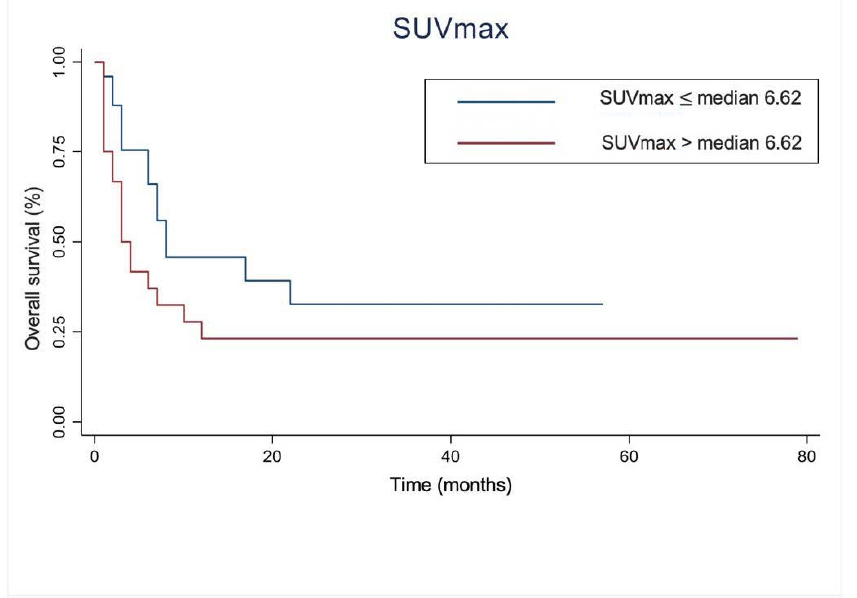
Figure 1. Kaplan–Meier curves for overall survival in restaging melanoma with respect to maximum standard uptake value (SUVmax).